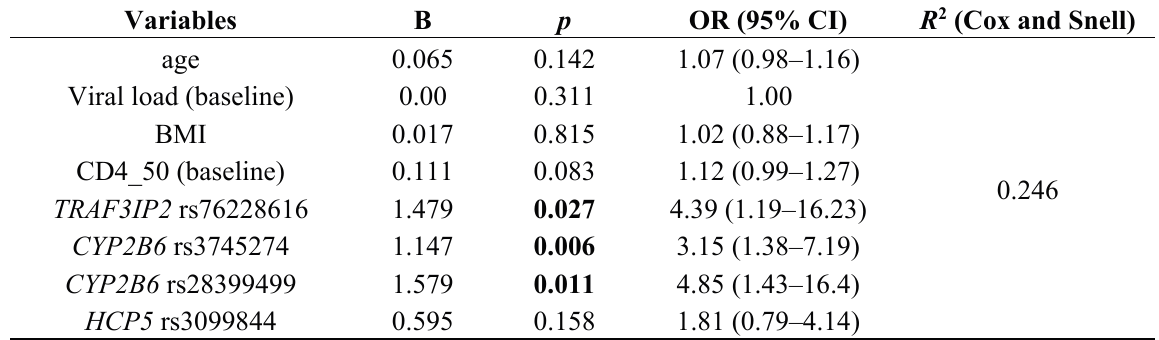
Table 3. Results of multiple logistic regression analysis.